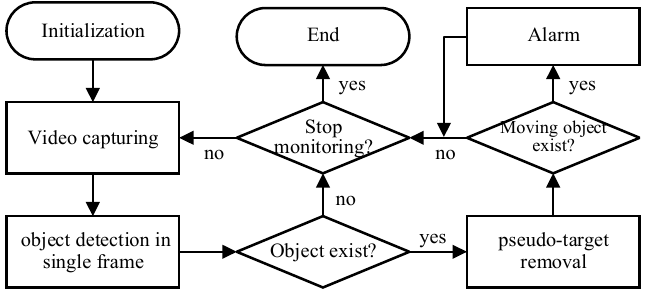
Figure 5. Workflow of the novel